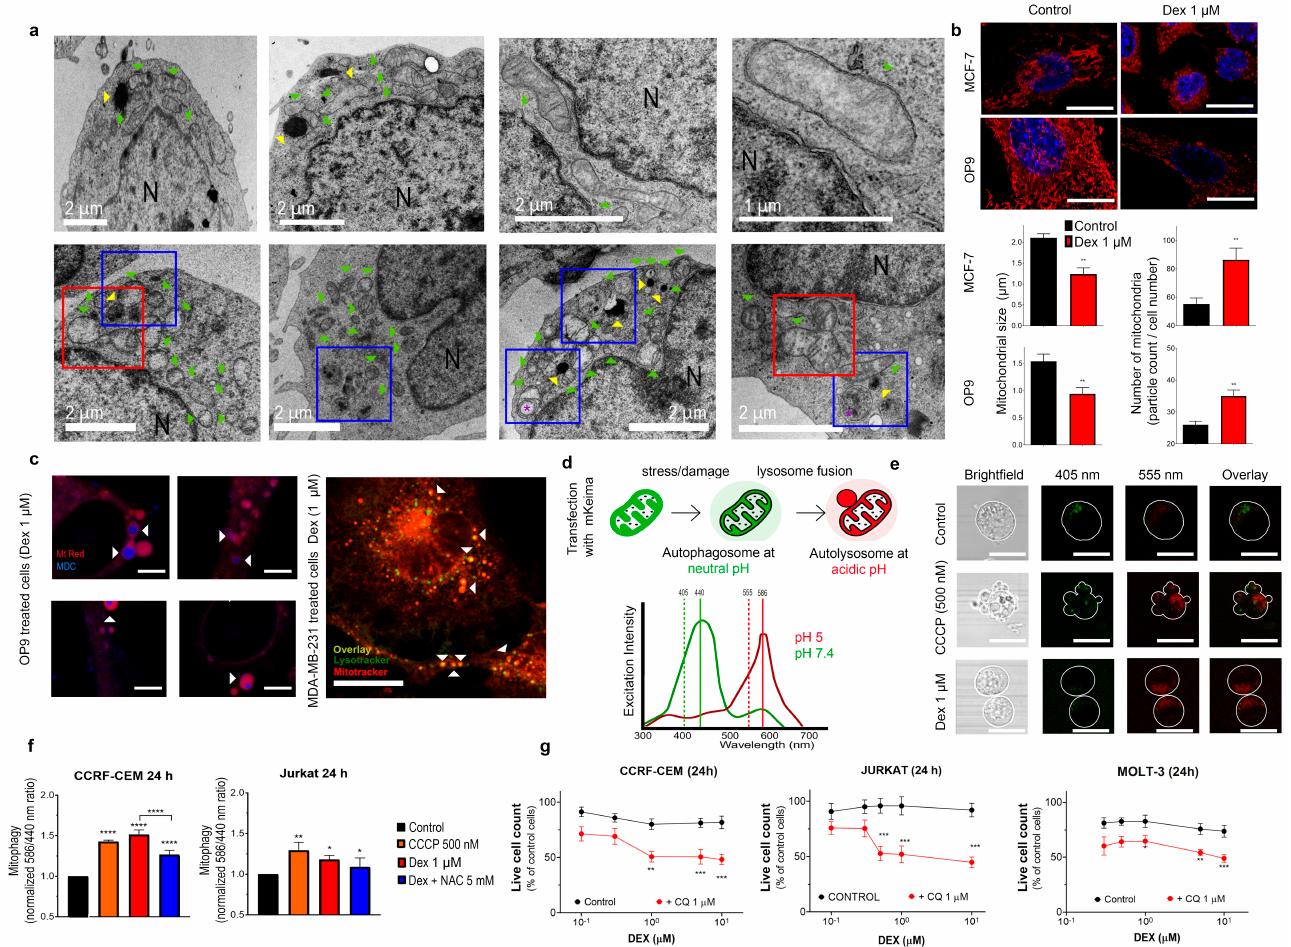
Figure 5. Dex causes structural changes in mitochondria and induces mitophagy. ( a ) High-resolution electron micrographs of CCRF-CEM cells under control (upper panel) and after Dex treatment (lower panel, 1 µM, 24 h). N: nuclei. Green arrows: mitochondria, yellow arrows: lysosomes, purple asterisks: double-membrane autophagosomes., red squares: mitochondria undergoing the fission process, blue squares: autophagic components close to lysosomes. Scale bars: 2 µm. ( b ) Representative confocal images of MCF-7 and OP9 cells co-stained with MtRed and Hoechst, either untreated or treated with Dex (upper panel). Scale bars: 10 µm. Quantitative analysis of MtRed-positive particles’ size and number (lower panel). Independent t-tests were performed. ( c ) Confocal images of OP9 (left) or MDA-MB-231 cells (right) co-stained with MtRed (red), MDC (blue), and Lysotracker (green). OP9 micrographs (left) show different zones in Z-stacked layers of a representative cell. White arrows indicate the proximity of mitochondria to acidic organelles. Scale bars: 2 µm (OP9) and 10 µm (MDA-MB-231). ( d ) Experimental strategy for the mitophagy detection with mtKeima (upper panel). The excitation spectrum of mtKeima at neutral (green) and acidic (red) pH (lower panel). Dotted lines: wavelengths corresponding to lasers used for excitation in confocal microscopy. ( e ) Representative confocal microscopy micrographs of CCRF-CEM cells transfected with mtKeima, untreated (control), and treated either with Dex (24 h) or CCCP (positive control). Scale bars: 10 µm. ( f ) Quantitative analysis of mitophagy through spectrofluorometry. The level of mitophagy was calculated as the ratio between the values of the maximum fluorescence obtained upon excitation at 586 nm and 440 nm (ratio 586/440). One-way ANOVA with Dunnet’s multiple comparison test was run. ( g ) Cell viability by trypan blue exclusion assay in T-ALL cells exposed to Dex alone (0–10 µM) and in combination with CQ (1 µM) for 24 h. Two-way ANOVA and Sidak’s multiple comparison tests were employed. In ( b , f , g ), data are mean ± S.E. for at least 4 independent experiments. * p <0.05; ** p <0.01; *** p < 0.001; **** p < 0.0001.